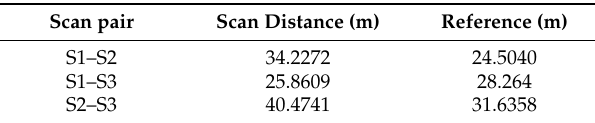
Table 3. Errors between estimated and reference transformation parameters: ∆φ , Δω and Δκ are rotation parameter errors corresponding to the x, y and z axes, respectively; ∆ x, Δ y and Δ z are translation errors along the x, y and z axes, respectively; RMSD is the root mean square deviation between two point clouds; and ∆ d S is the error of the distance between two adjacent scan positions.